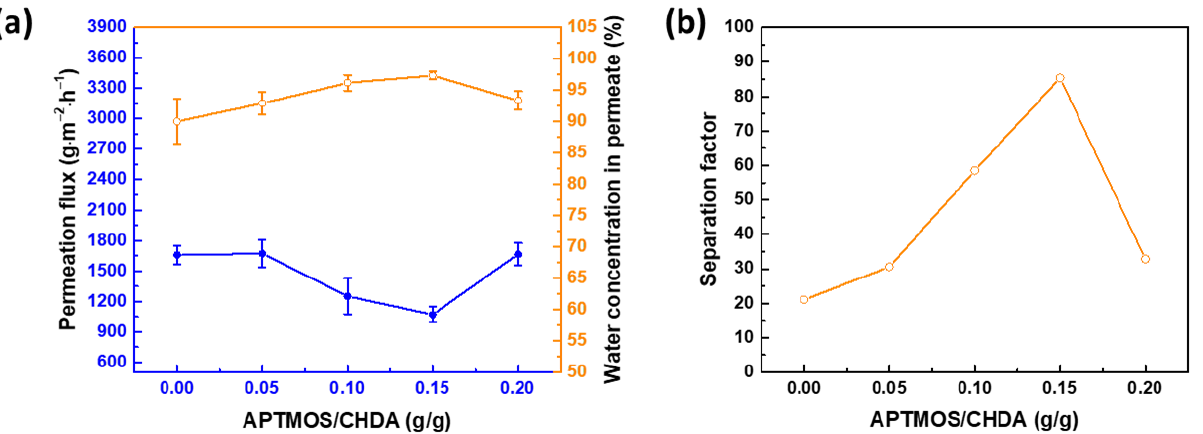
Figure 6. Effect of the APTMOS/CHDA ratio on pervaporation membrane performance, as a function of ( a ) permeation flux and water concentration in permeate and ( b ) separation factor. Time for mixing CHDA and APTMOS = 60 min; reaction temperature = 30 °C; concentration of IPA = 70 wt%; downstream pressure = 1 mmHg; and operating temperature = 25 °C.